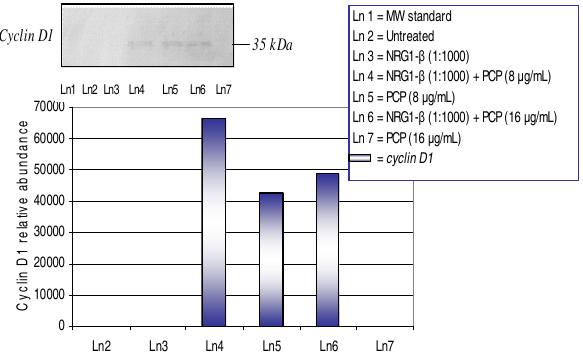
Figure 7: Expression and relative abundance of cyclin D1 in AML 12 mouse hepatocytes exposed to PCP and NRG1- β + PCP for 48h. Cyclin D1 protein identification was assessed following exposure incubation period of 48 h. Inset shows a representative Western-blot analysis.